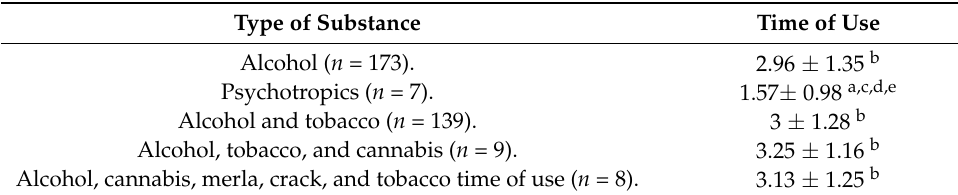
Table 4. Time of consumption in decades of substances with higher frequency of use among the elderly people assisted by the CAPS-AD in DF from 2000 to 2017. Type of Substance Time of Use Alcohol ( n = 173). 2.96 ± 1.35 b Psychotropics ( n = 7). 1.57 ± 0.98 a,c,d,e Alcohol and tobacco ( n = 139). 3 ± 1.28 b Alcohol, tobacco, and cannabis ( n = 9). Alcohol, cannabis, merla, crack, and tobacco time of use ( n = 8). 3.13 ± 1.25